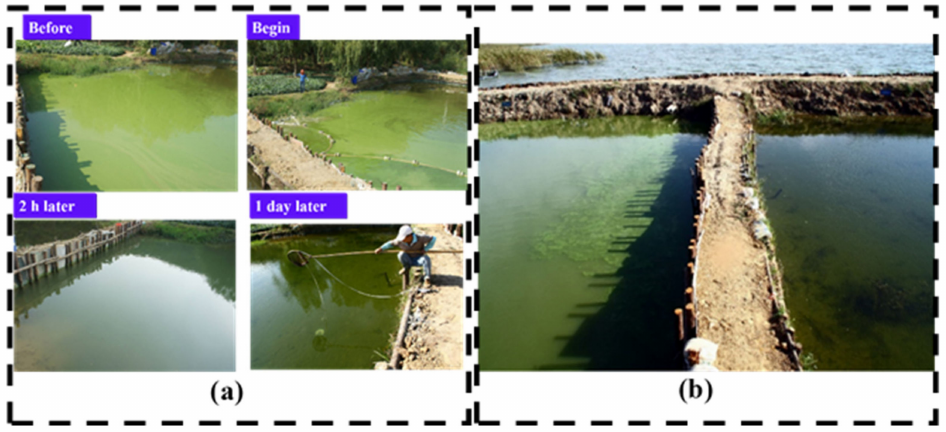
Figure 5. Application of MLS treatment at the Tanxi Bay research site. ( a ) Visual change of the treatment pond in 1 day; and ( b ) control (left) and treatment (right) ponds after 20